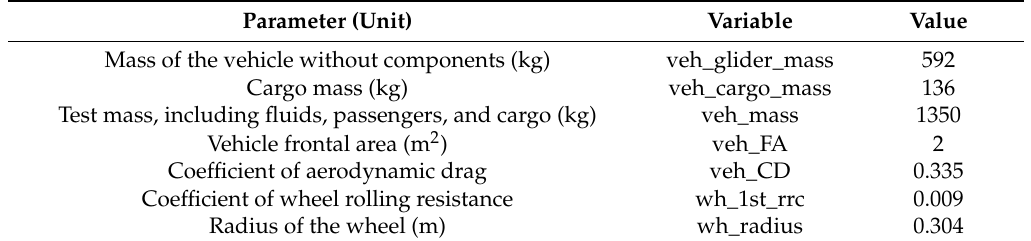
Table 6. Parameters for the used parallel HEV